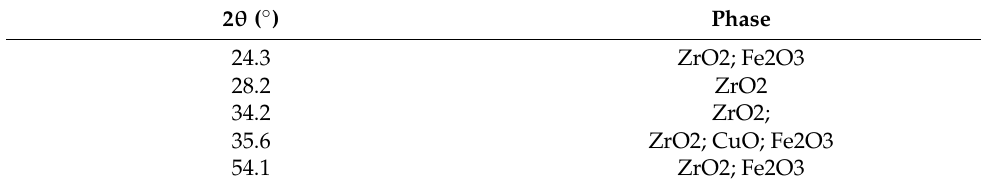
Figure 1. XRD profiles of the investigated bimetallic formulations ( (cid:72) monoclinic ZrO 2 , (cid:108) tetragonal ZrO 2 ). Table 2. Assignment of signals in XRD